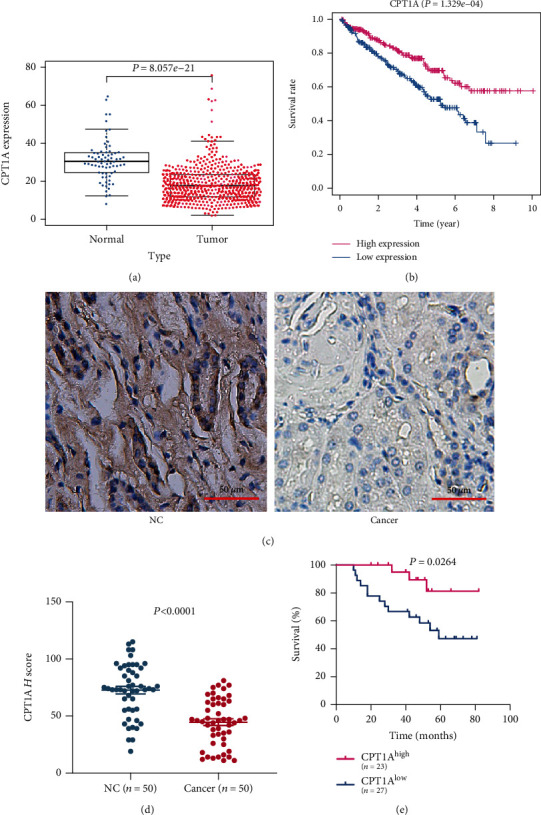
CPT1A is downregulated in KIRC and is associated with the overall survival rate of KIRC patients. (a) The scatterplot of CPT1A expression in the KIRC dataset of the TCGA database. (b) The survival curve of CPT1A obtained using the KIRC dataset of the TCGA database. (c) Typical immunohistochemical images of CPT1A in kidney cancer tissues and normal kidney tissues. (d) Scatterplot of the H scores of CPT1A expression in 50 cancerous and normal kidney tissues. (e) Survival curve obtained based on the clinical data of kidney cancer patients collected by us.